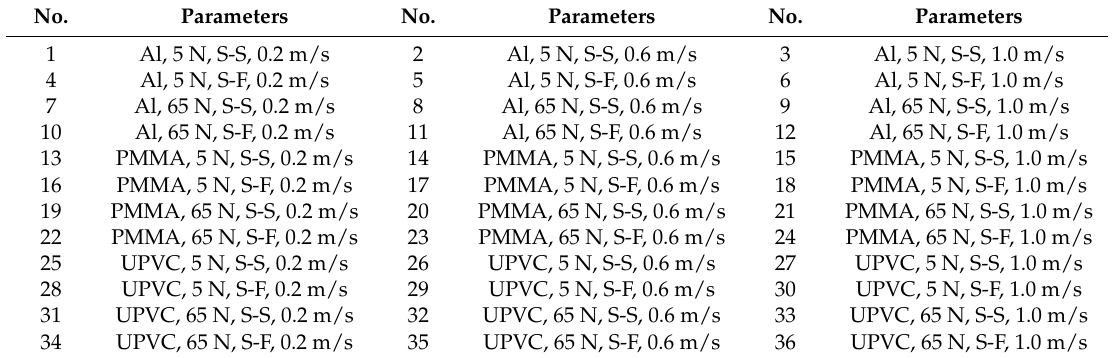
Table 3. Experiment